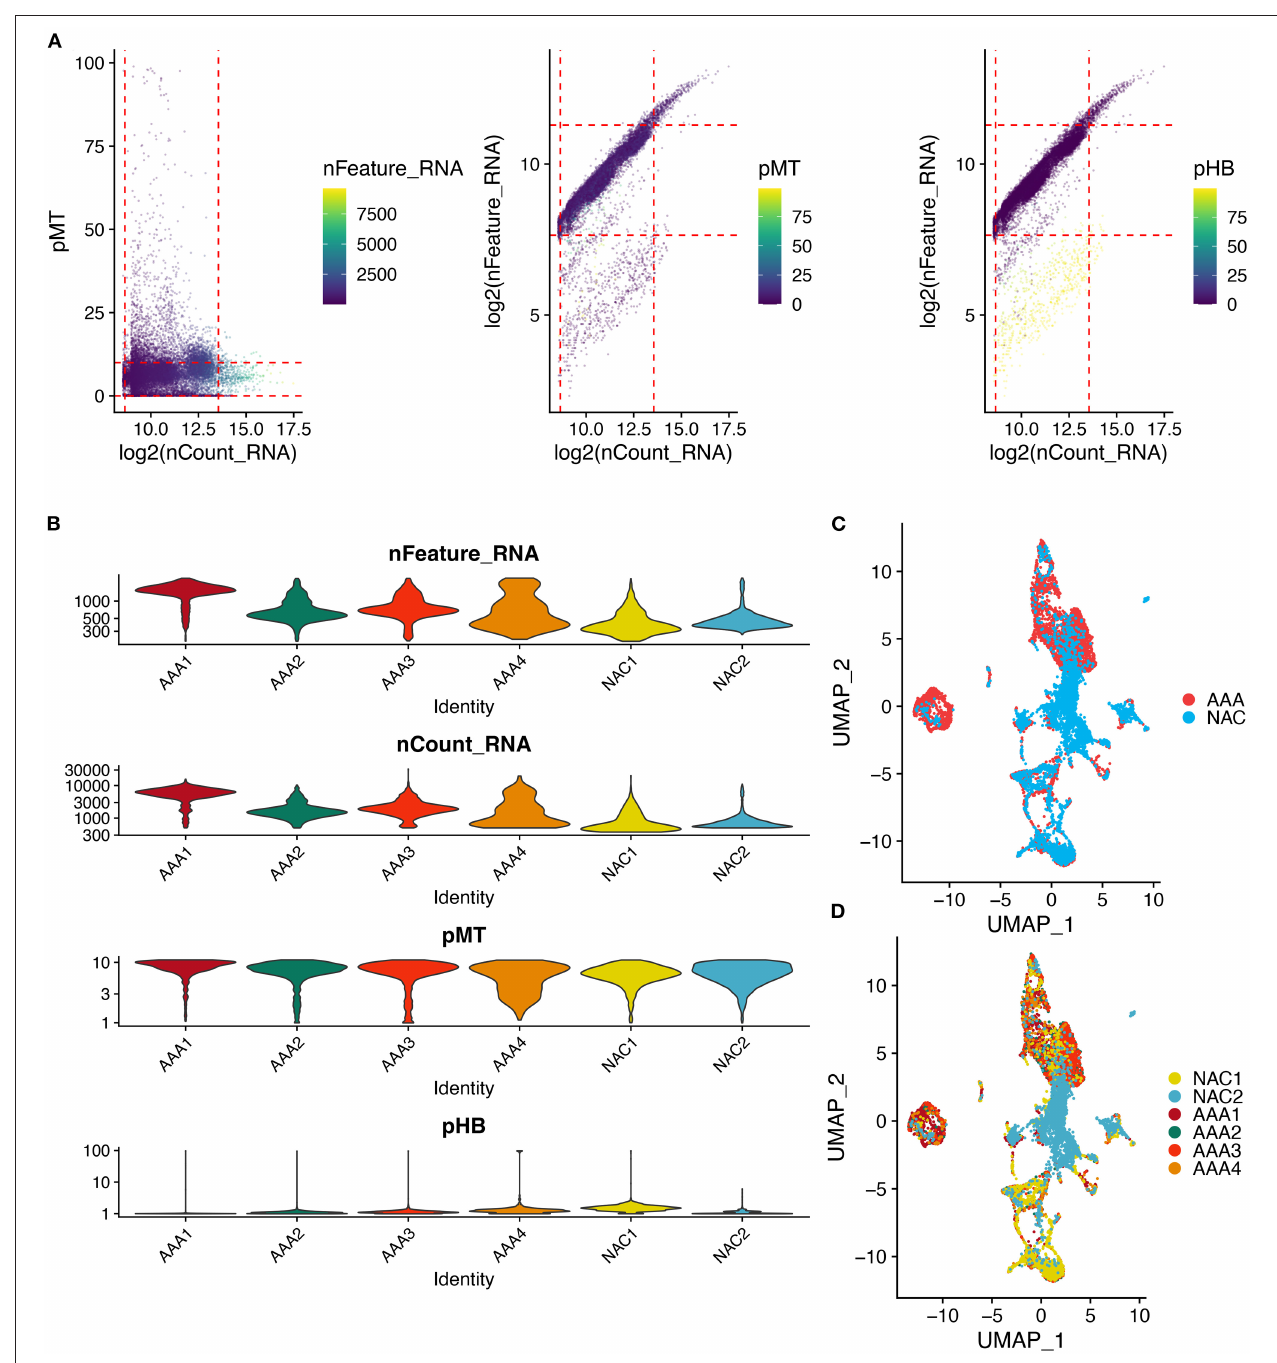
FIGURE 1 | Quality control and cell clustering of single cell data. (A) Scatter plot of quality control metrics for scRNA-seq data. The red dashed line represents the threshold used to filter out high quality transcriptomic data. pMT: percent of mitochondrial counts; pHB: percent of hemoglobin RNA counts. (B) Violin plots showing the distribution of cell characteristics after quality control. (C,D) . UMAPs show the results of cell clustering based on the top 30 principal components, color coded by (C) tissue type, or (D) patient. addition, the proportion of monocytes/macrophages differed significantly between samples in the AAA group.